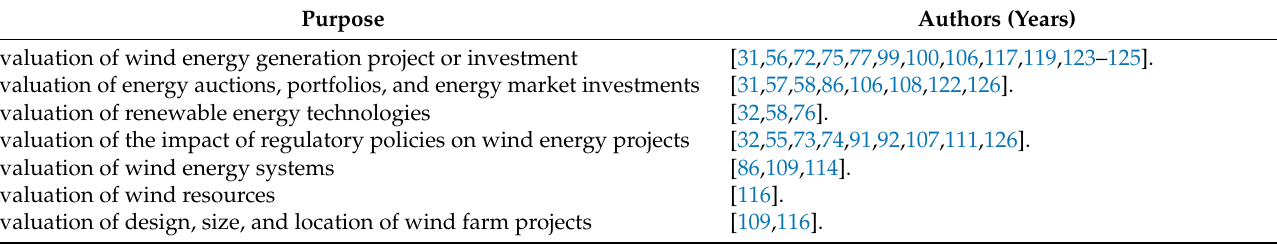
Table 3. Investigations according to the purpose of the application in the framework of the real options